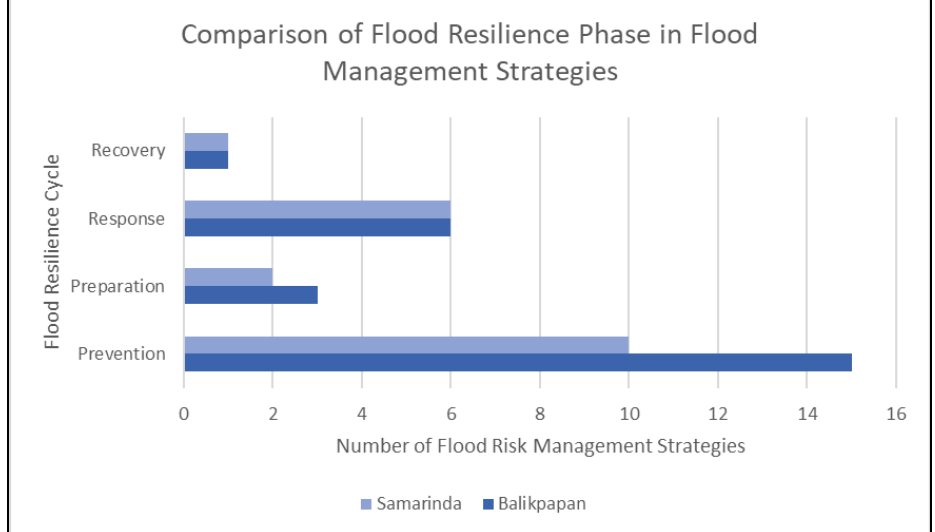
Figure 4. Flood management strategies in government documents as per the flood resilience phase .